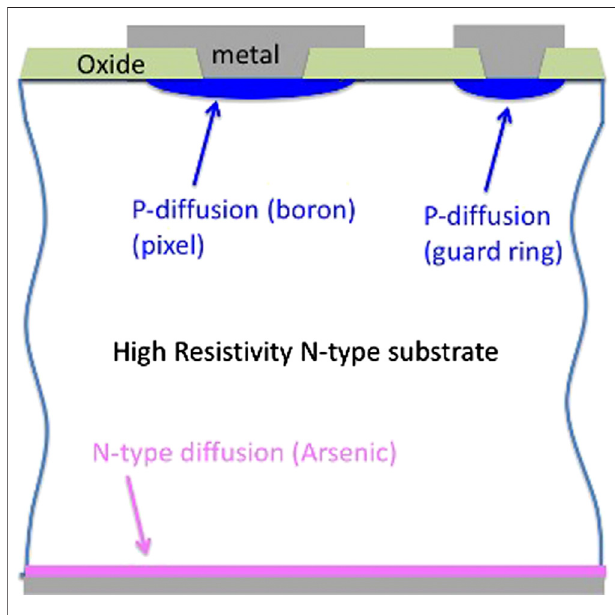
FIGURE 2 | Schematic cross-section of SLAC in-house planar sensor process. The n-type Arsenic pro fi le constitutes the entrance window.